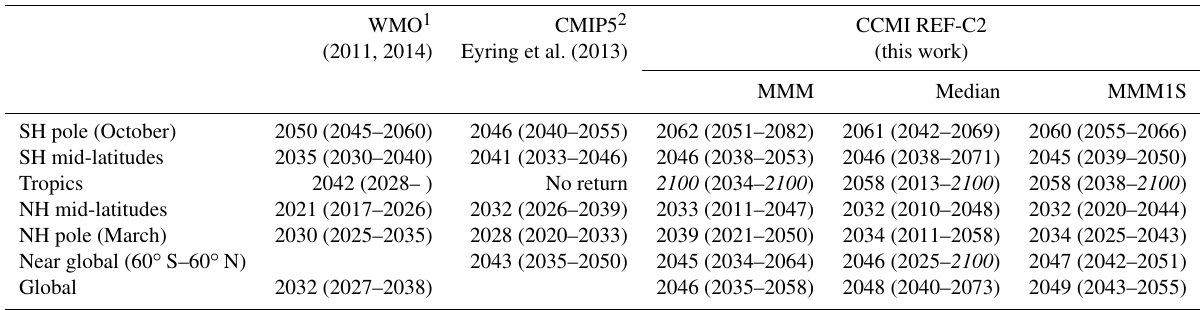
Figure 2. MMM1S total column ozone time series (DU) from REF-C1 (blue), REF-C1SD (dark cyan), and REF-C2 (red) simulations for the (a, c) SH polar (October) and (b, d) NH polar (March) regions. The dashed black lines show the 1980 reference value for each latitude band. The shaded regions show 1 σ variability with respect to the MMM1S lines of the same colour. The top row shows the unadjusted modelled values and the bottom row shows the time series adjusted with respect to mean 1980–1984 observations and after application of a 10-point boxcar smoothing. Also shown are the merged SBUV observations. Table 3. Total column ozone (TCO) return dates to 1980 baseline from REF-C2 simulations using different averaging methods. Values in brackets indicate recovery dates based on either 1 σ standard deviation or 10th and 90th percentile estimates. The number 2100 in italics indicates that the estimated ozone uncertainty range has not returned to the 1980 values within the time range of the model simulation. The MMM for RCP 6.0 derived from the CMIP5 models (Erying et al., 2013b) is shown in column two. An entry of “No return” for the tropics means that ozone does not return to 1980